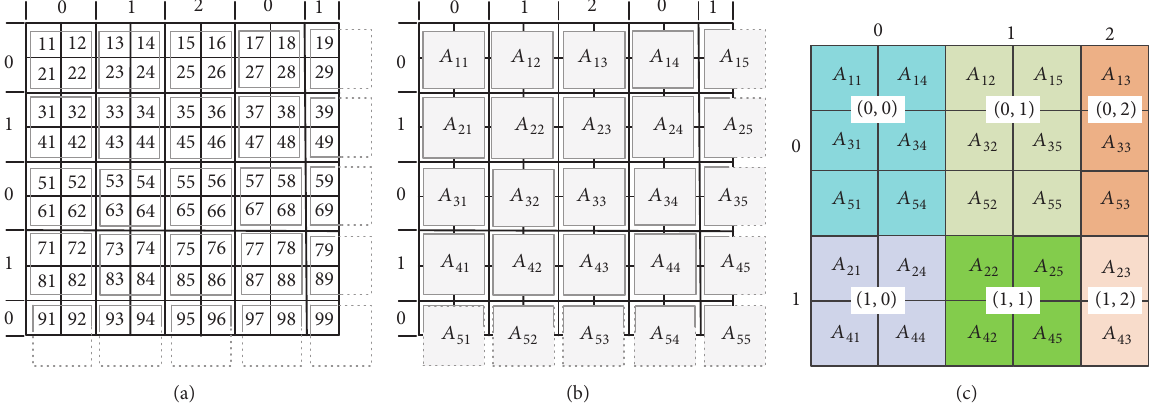
Figure 3: 2D block-cyclic distribution scheme: (a) matrix A divided into 2 × 2-sized blocks, (b) the matrix A is consisting of 5 × 5 blocks, and (c) the rearrangement of 𝐴 𝑚𝑛 in (b) for each process.